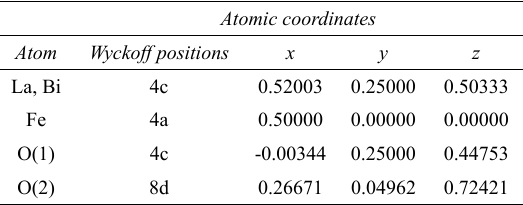
Table 1. Relevant lattice parameters for the LaBiFe perovskite in the Pnma space group.